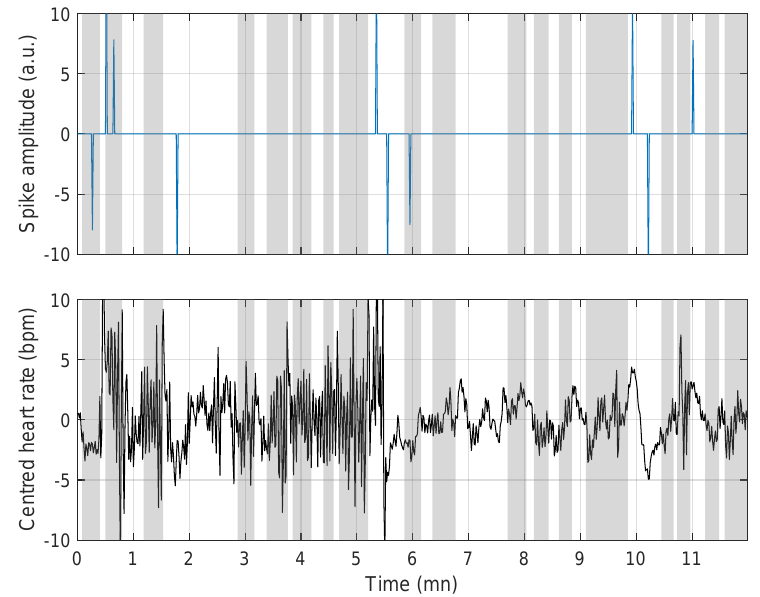
Figure 11. Same representation as in Figures 9 and 10. Example of under-estimation; in the latter case, there seems to be no link between events in the heart rate and ground-truth